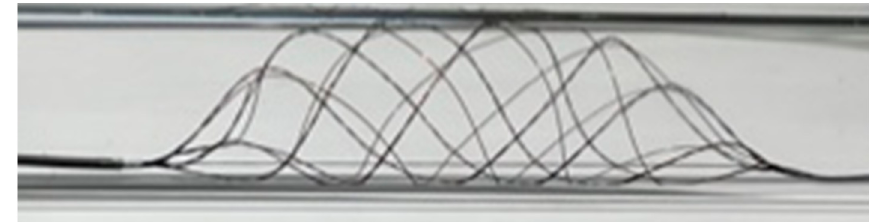
Figure 1. Expanded mesh of the Tigertriever XL Device.